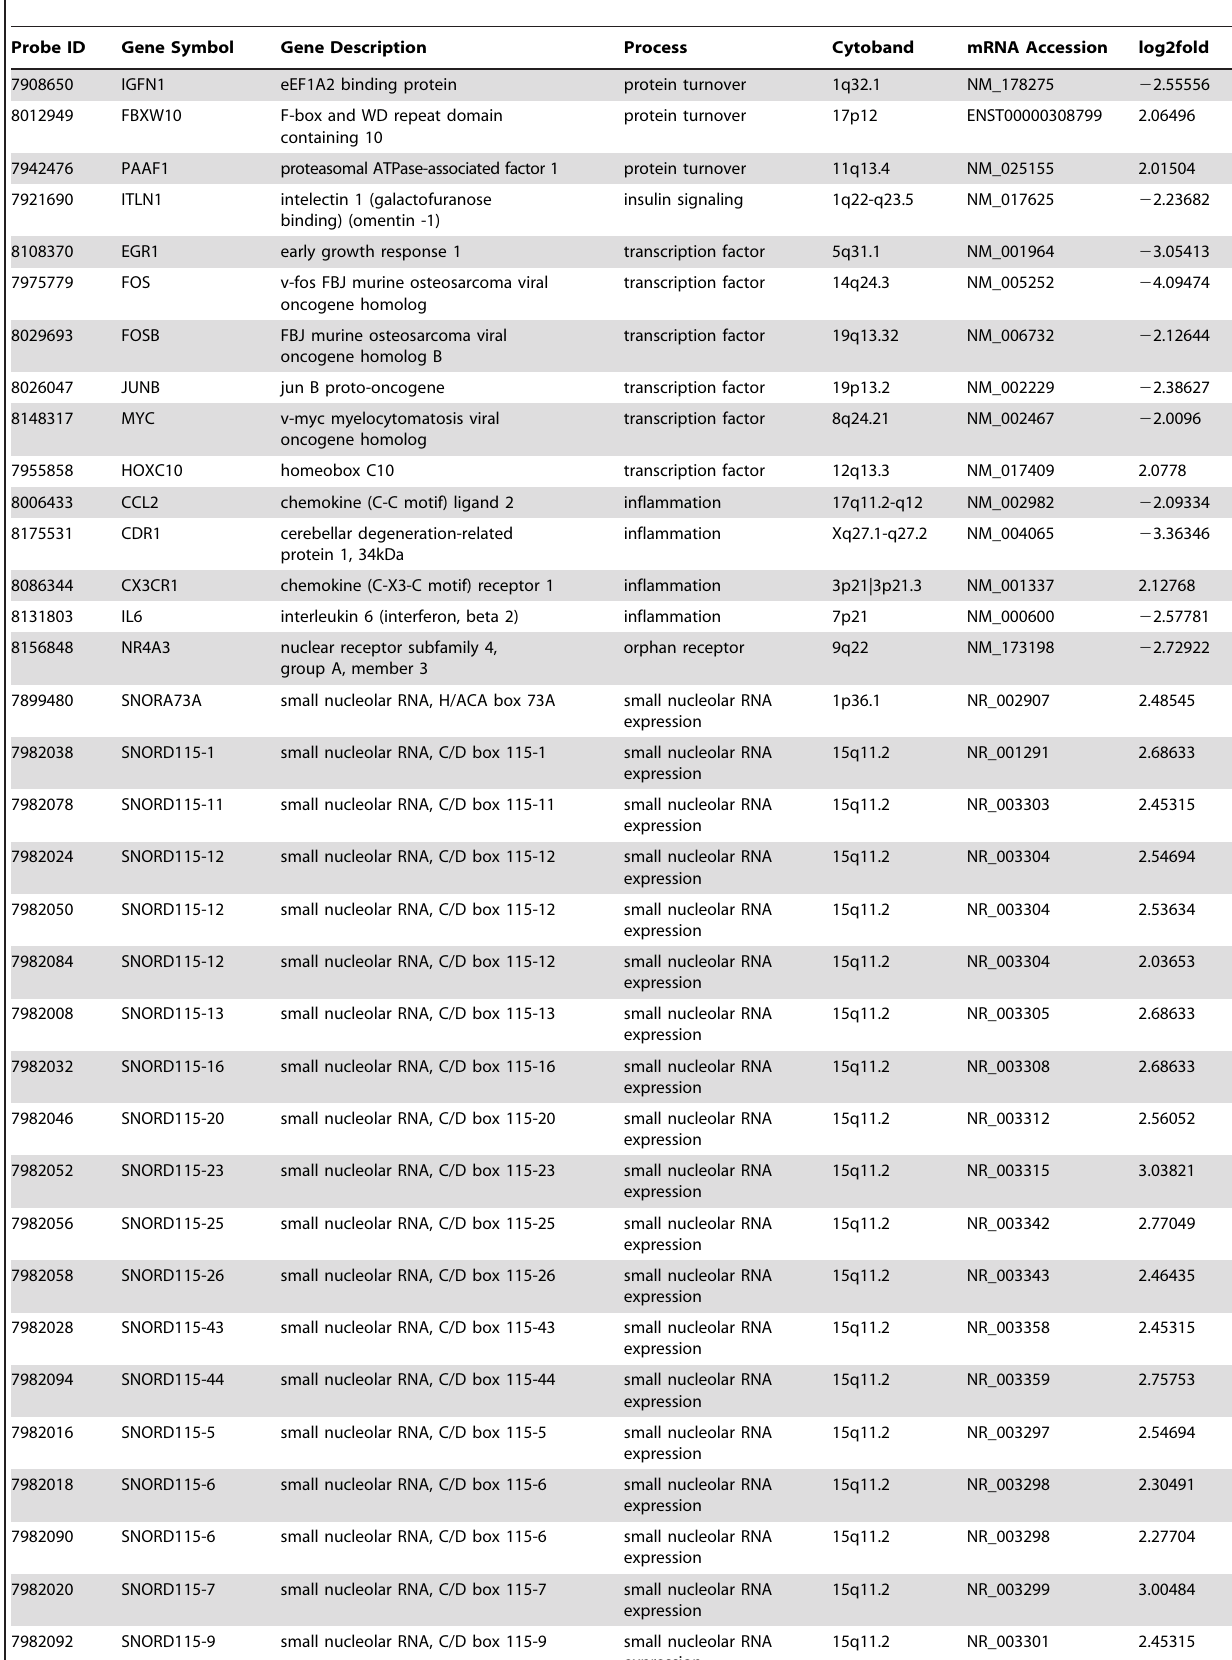
Table 4. Genes changed $ 4 fold (log 2 base $ 2) between 12 and 0 months no omentectomy.